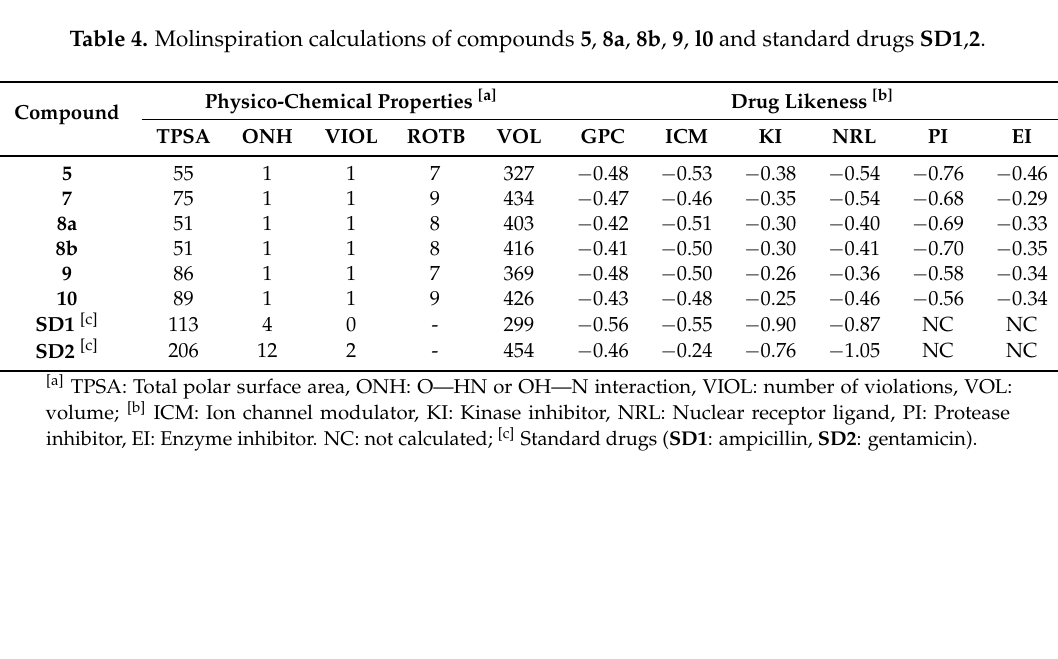
Figure 10. Repartition of partial π -charges of N, O and S atoms of compounds 5 – 10 . The possible antibacterial and antifungal pharmacophores are marked in red and blue color, respectively.